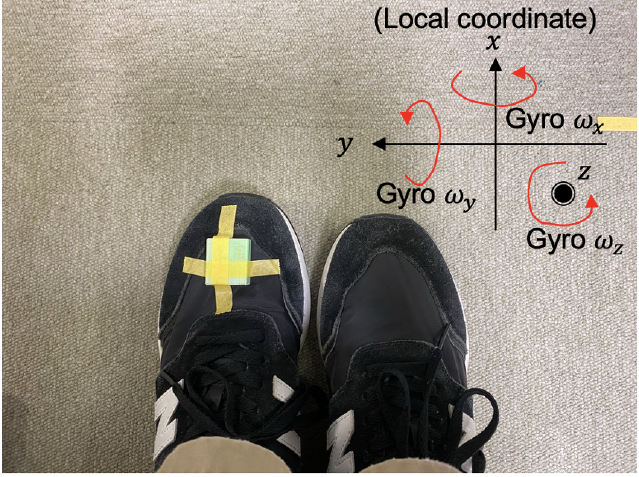
Figure 9. The placement location of the IMU sensor on a shoe. The gait-phase-estimation algorithm should be improved from the data in Table 1. Estimation error of mid-stance was about 7.34% in average. However, each estimation error is scattered. A reliable gait-phase-estimation algorithm should have a lower error and low variance. Table 1. The results of Experiment 1.